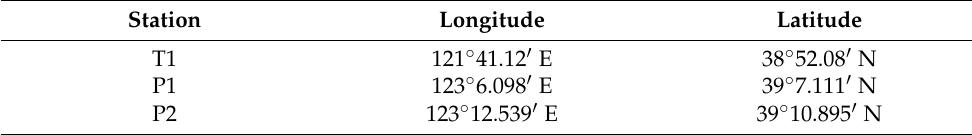
Table 1. Coordinates of the hydrometric stations for hydrological tide tests.